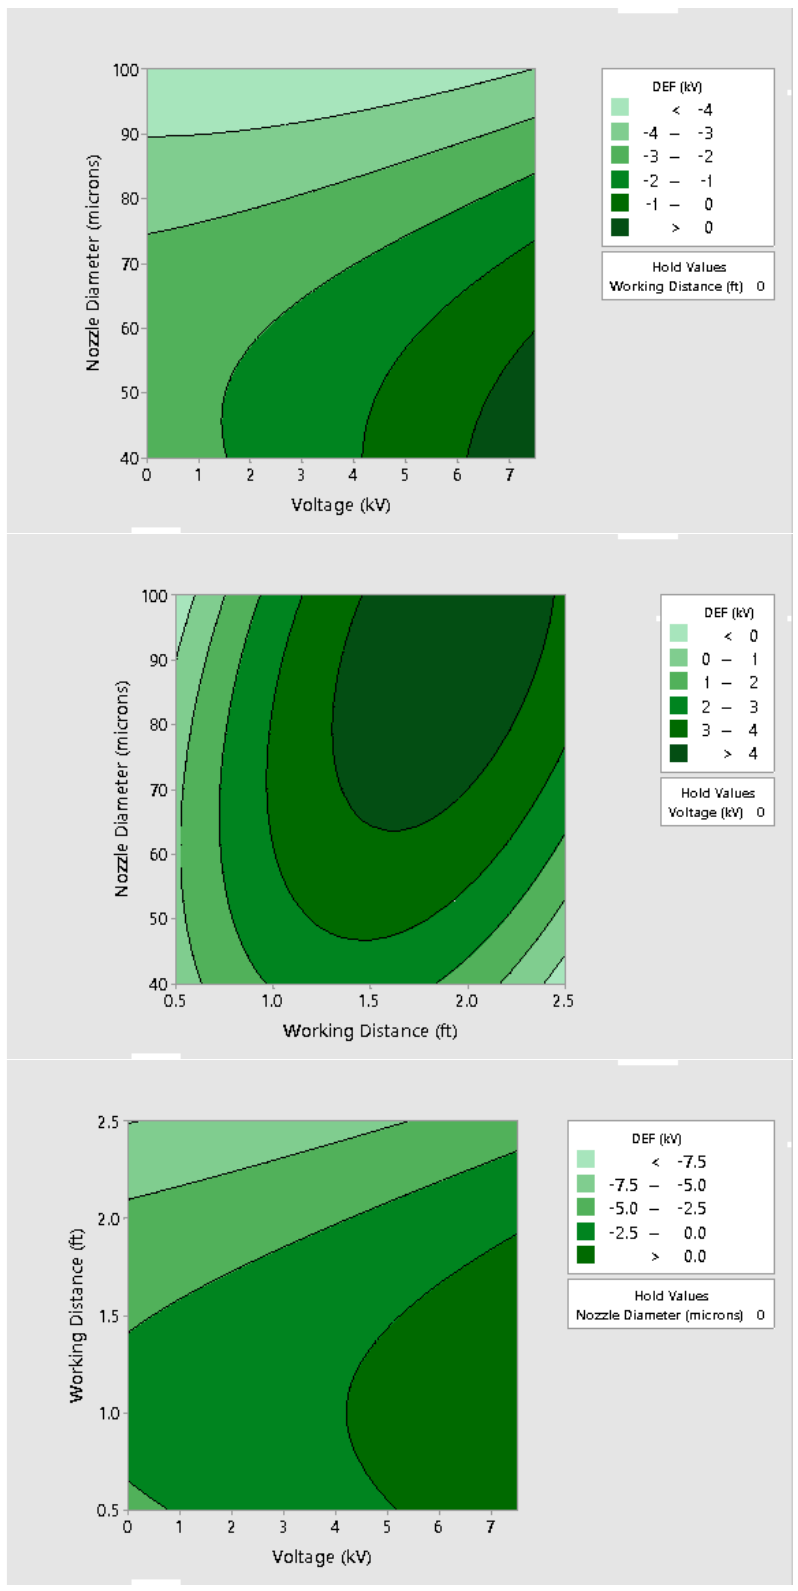
Figure A26. Rubber: quantitative representation of average differential electric field vs. working distance (feet), nozzle sprayer size ( µ m), and charge voltage